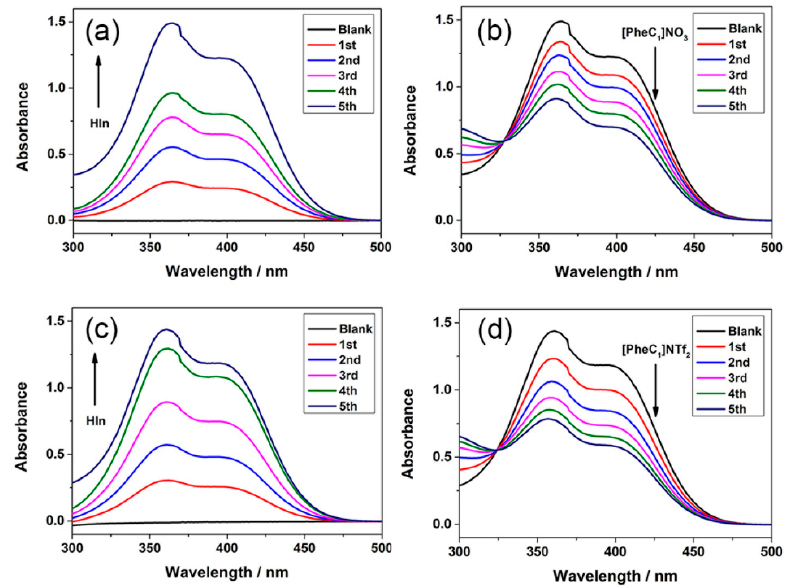
Figure 2. Absorption spectra of the 2,4-dinitrophenolate ion for various adding amounts of the indicator or [AAE]X during the titration in ethanol. ( a ) Adding the indicator before the titration of [PheC 1 ]NO 3 . ( b ) Adding [PheC 1 ]NO 3 during the titration. ( c ) Adding the indicator before the titration of [PheC 1 ]NTf 2 . ( d ) Adding [PheC 1 ]NTf 2 during the titration. Table 4. The p K a values of [AAE]X and the contrastive compounds in ethanol.